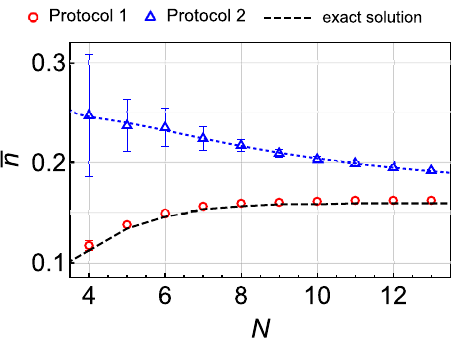
Fig. 3 Asymptotic excitation numbers. Numerically found fi nal normalized excitation numbers (cid:2) n (cid:2) h n i = ðð N (cid:3) 1 Þ = 2 Þ for various numbers of spins at g = 2 and Ising Hamiltonian (2) with the coupling coef fi cients independently drawn from the standard normal distribution. Blue dots correspond to the transverse fi eld protocol, and red dots are numerical con fi rmation of the analytical prediction for the solvable model, which is marked by a dashed black curve. Error bars show the standard deviations of the data points obtained from averaging over 25 realizations of the random Hamiltonian. A Blue dotted curve is the best fi t to ∑ 4 c k = N k , which k ¼ 0 predicts that the exact solution has better performance for any N .